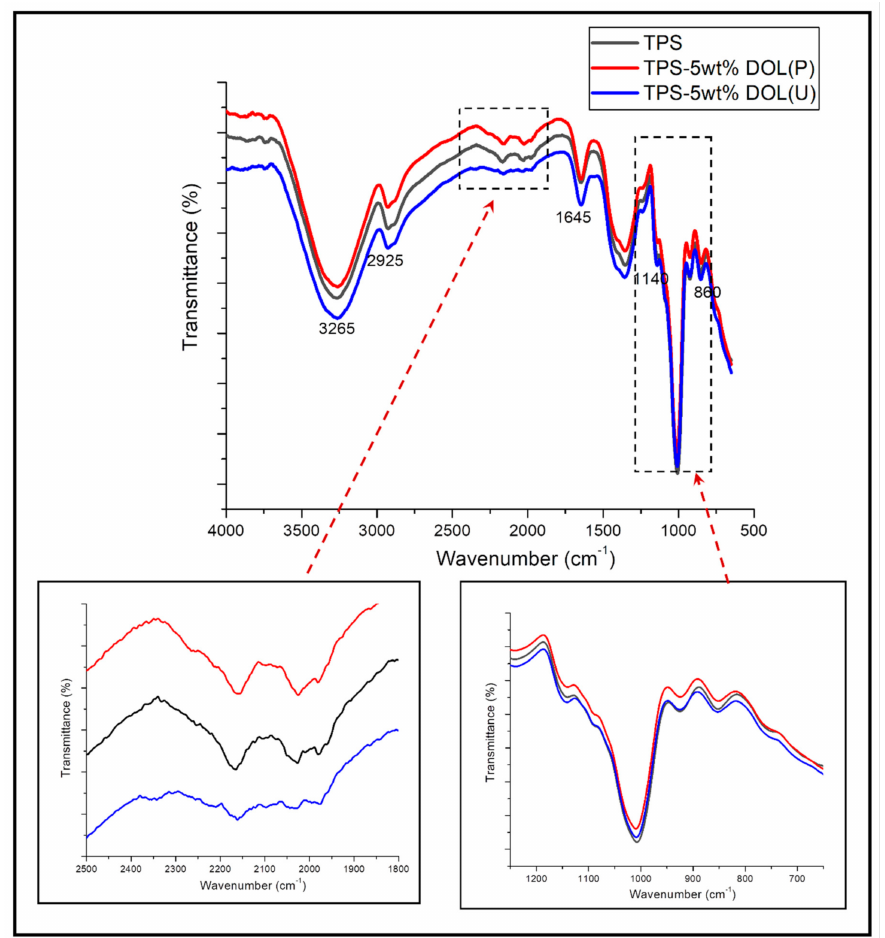
Figure 7. FTIR spectra of thermoplastic starch (TPS) film and TPS-5wt%DOL biocomposites